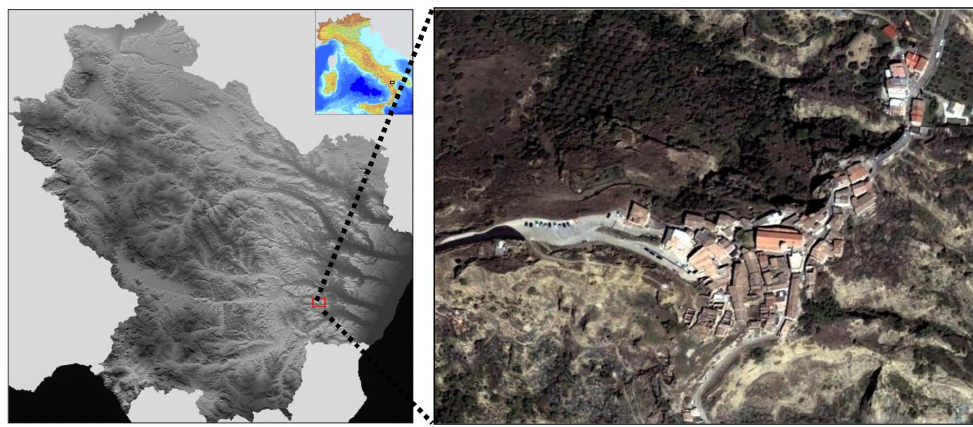
Fig. 1. Geographical location of the study area and satellite image of Rabatana site.